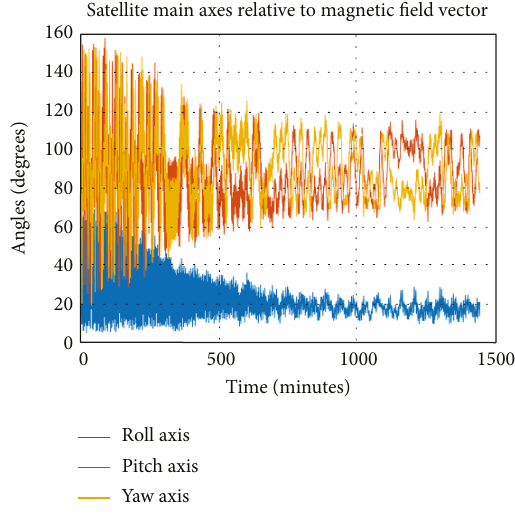
Figure 6: Simulated 3U CubeSat at ISS orbit, neglecting aerodynamic torques. This fi gure shows the angles of the spacecraft ’ s primary axes and the magnetic fi eld vector. After approximately 800 minutes of settling time, the satellite appears to successfully track the magnetic fi eld within 30 degrees. Results are falsely optimistic when neglecting aerodynamics, as described in Figures 9 and